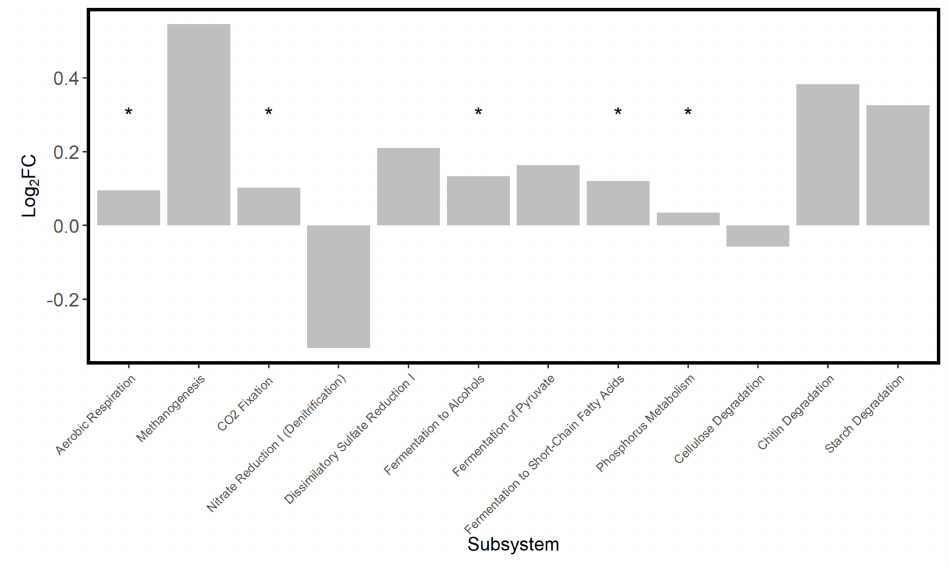
Figure 5. Di ff erential abundance of MetaCyc subsystems in microbial communities in saltpan wetland sediment when hydrated compared to desiccated. Log 2 FC, fold change, represents the shift from the desiccated to the hydrated state and those functional groups which were represented by more amplicons following the flood event show positive change and those which had fewer amplicons show negative change. MetaCyc enrichment analysis determined which functional groups showed a significant change (*), based on the raw number of daughter pathways which changed in amplicon number.